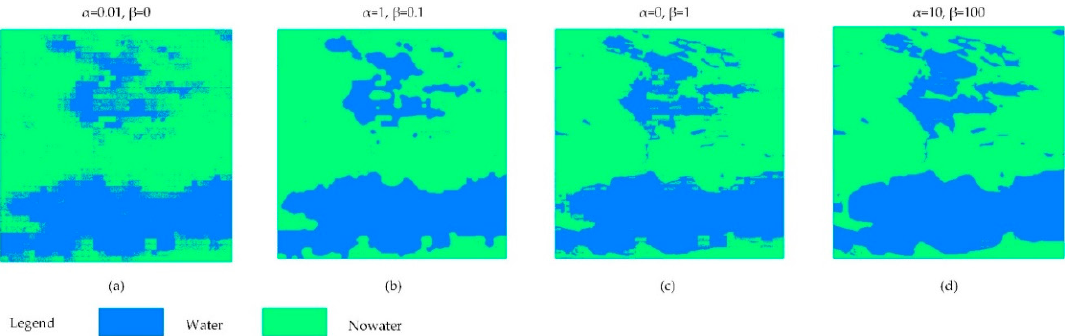
Figure 9. Resultant water body maps of MSST_SRM under different values of α and β : ( a ) α = 0.01, β = 0; ( b ) α = 1, β = 0.1; ( c ) α = 0, β = 1; ( d ) α = 10, β = 100.